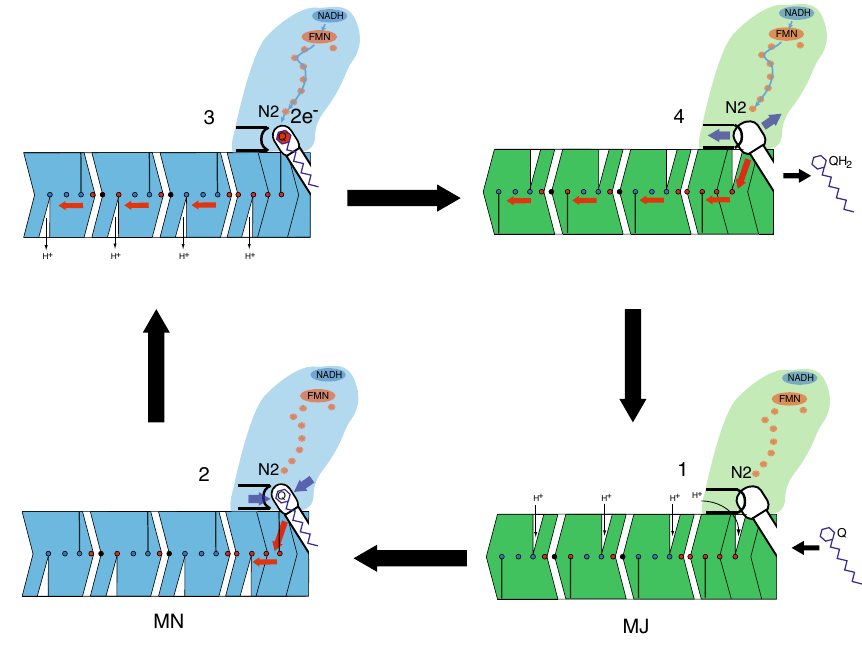
Fig. 9 The coupling mechanism of complex I. The two main states of the complex are shown in green (major-like MJ states, represented by CXI INT , CXI NADH , and CXI MJ structures) and blue (minor-like MN states, represented by CXI DQ and CXI MN structures). It is expected that in the membrane such two states would largely correspond to the proton channels opened either to the cytosol (MJ) or to the periplasm (MN). In state 1 the enzyme is waiting for quinone to bind. The complex is reduced so that key Nqo4 β 1 – β 2 loop with H38 is fl ipped into the Q cavity (black arc). In state 2, upon quinone binding, this loop retracts, allowing quinone to reach the deep end of the cavity. The cavity “ tightens ” around the headgroup (blue arrows), the enzyme converts into the MN state and conformational changes propagate into the E-channel (red arrows). In state 3, two electrons from NADH arrive to quinone via cluster N2, the quinone is protonated to quinol and the double negative charge resides on proton-donating residues H38 4 and Y87 4 (depicted as red Q headgroup for simplicity). Electrostatic interactions with charged residues in the E-channel initiate further changes propagating (either conformationally or electrostatically) into antiporter-like subunits (red arrows), resulting in the ejection of protons into the periplasm. In state 4, the enzyme is quickly re- reduced and H38 4 fl ips out (black arc). Facilitated by this and the expansion of the cavity (blue arrows), quinol is ejected into the lipid bilayer and the enzyme reverts to a MJ-like state. The cycle resumes at state 1, with further details outlined in the